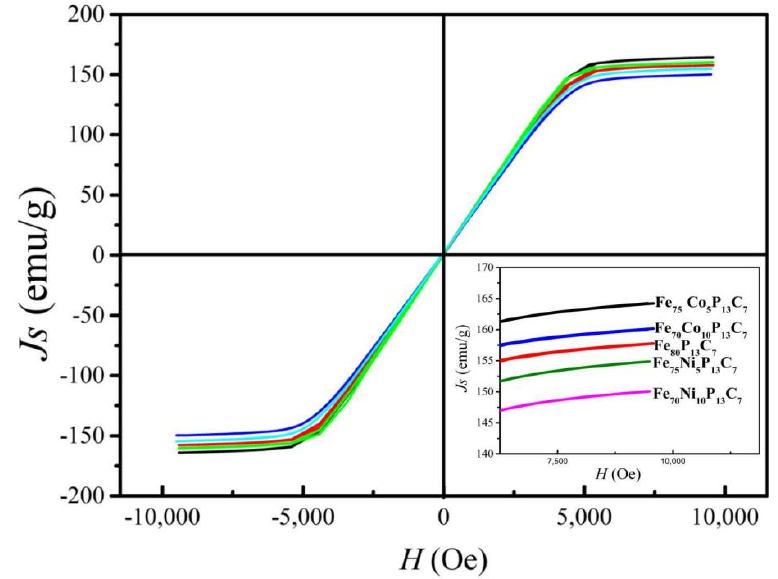
Table 1. The maximum diameter for fully glass formation ( D max ), magnetic transition temperature ( T C ), the saturation magnetization ( J s ) and magnetocaloric properties at the magnetic applied field of 1.5 T and 5 T for the present Fe 80-x M x P 13 C 7 (M = Co, Ni; x = 0, 5 and 10 at.%) BMGs. Composition